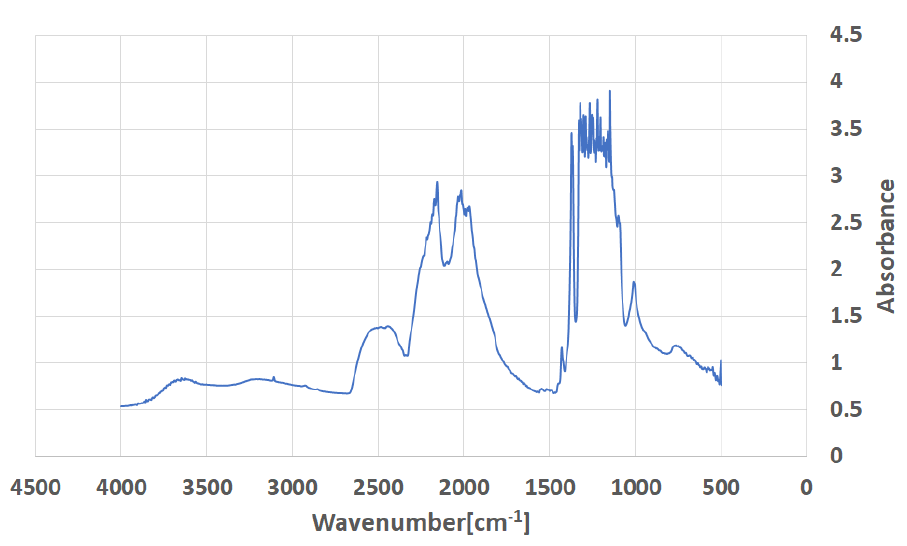
Figure 5. The infrared absorption spectra of the H master diamond. The absorption values at 1095 cm − 1 is 1.14.